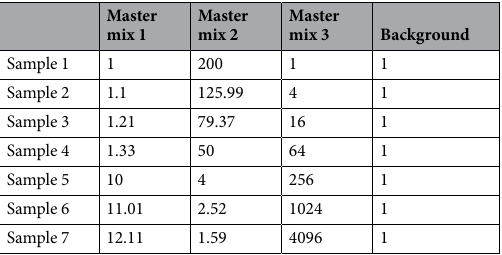
Table 1. Summary of the relative concentrations of the spike-in samples in the DIA profiling standard used in assessing the performance of